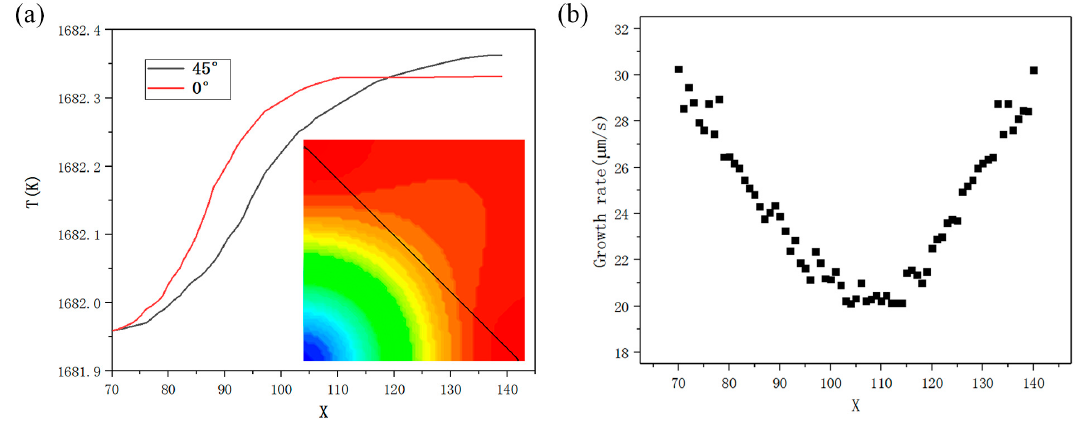
Figure 4. ( a ) Temperature distribution curve of 0° and 45° in x–z section and ( b ) velocity distribution scatter diagram of solid-liquid interface.